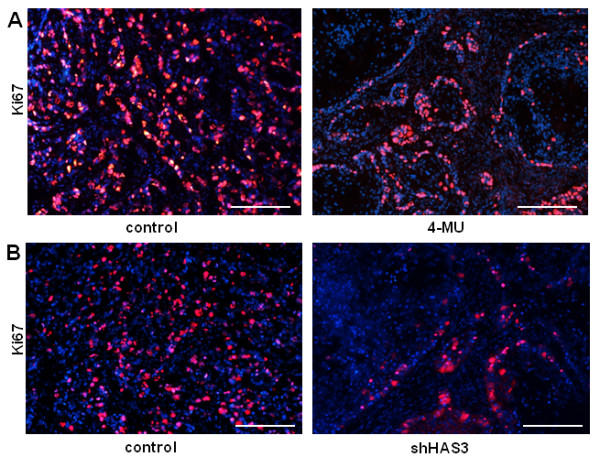
Effects of 4-MU and tumour cell targeted shHAS3 on proliferation in OSC1 xenografts. (A) 4-MU, staining of human Ki67 (red) was markedly reduced by 4-MU treatment and confined to the interface between tumour cells and stroma. (B) shHAS3, staining of human Ki67 (red) was markedly reduced in tumour cells transduced with shHAS3. Scale bars 200 μm. Shown are representative images of n = 6 (control) and n = 7 (shHAS3) experiments.